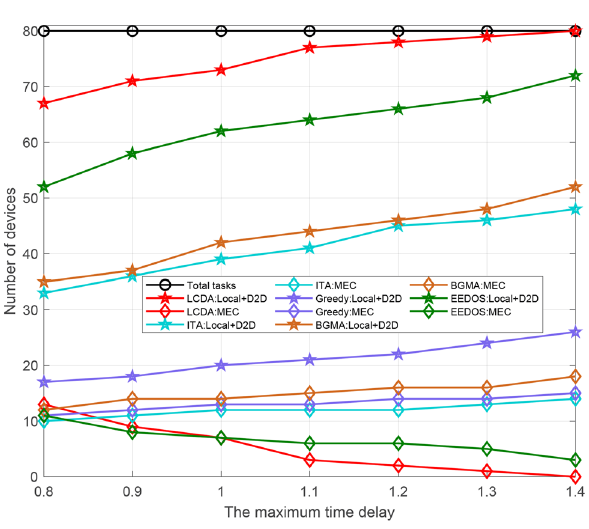
Figure 10. The number of devices versus the maximum time delay of different modes (N =